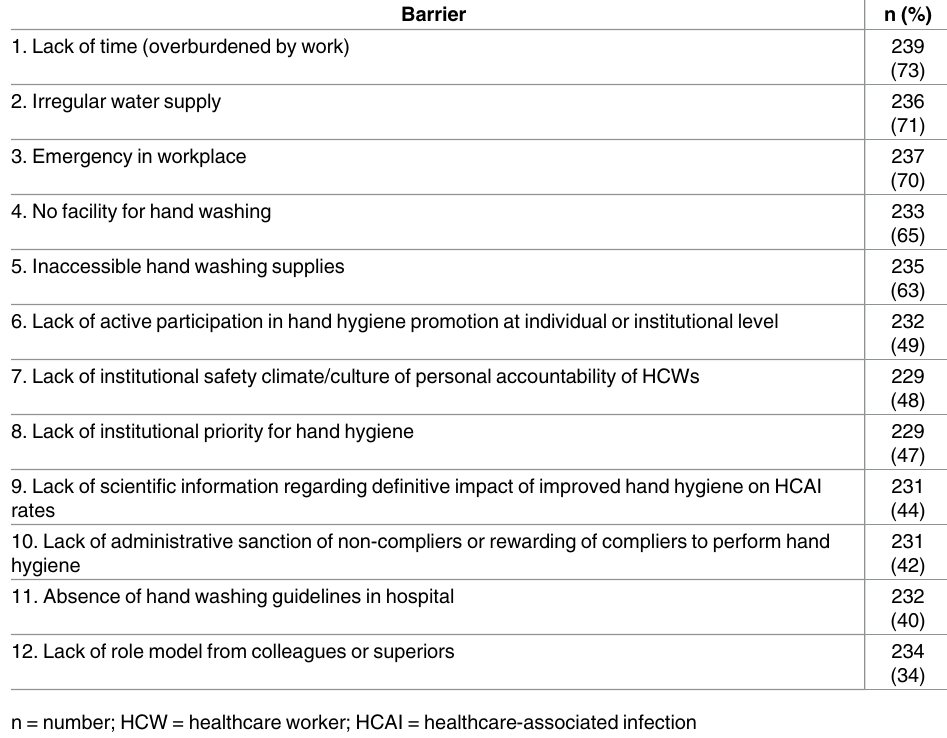
Table 6. Perceivedmain barriers for non-compliance with hand hygiene amongst study population.